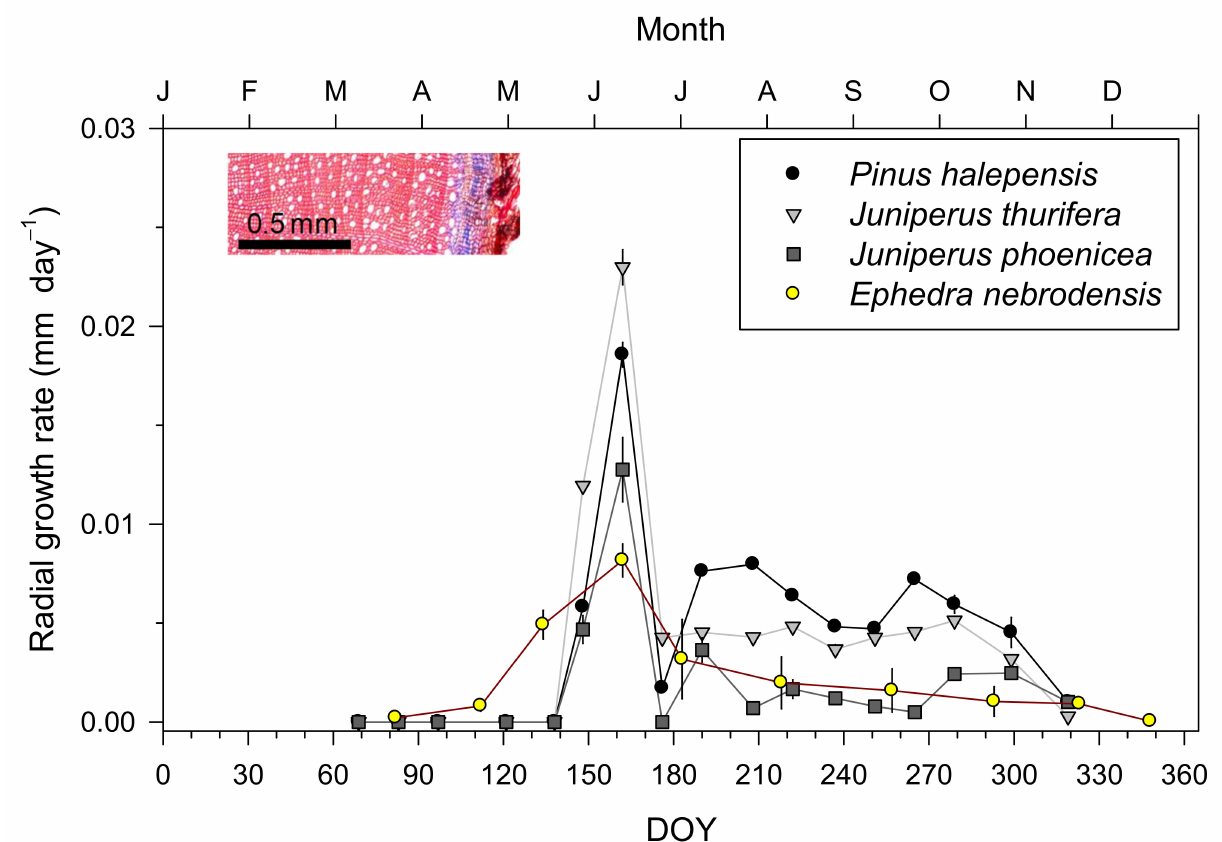
Figure 2. The intra-annual radial growth rates were calculated for the four study species in the very dry site. Values are means ± standard errors. The right y -axis corresponds to Ephedra rates. The image shows a stained Ephedra cross-section sampled in May showing recently formed xylem as blue cells. DOY: day of the